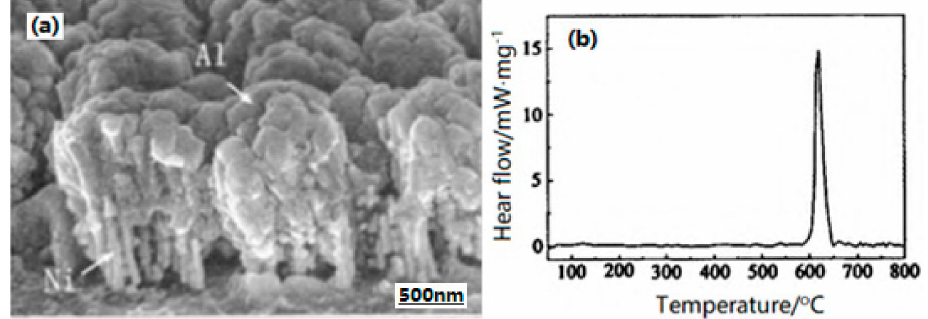
Figure 8. SEM and DSC curve of Al / Ni nano-sized composite. ( a ) SEM of Al / Ni nano-sized composite; ( b ) DSC curve of Al / Ni nano-sized composite. Reproduced from [44], with permission from Huo Zha Yao Xue Bao,